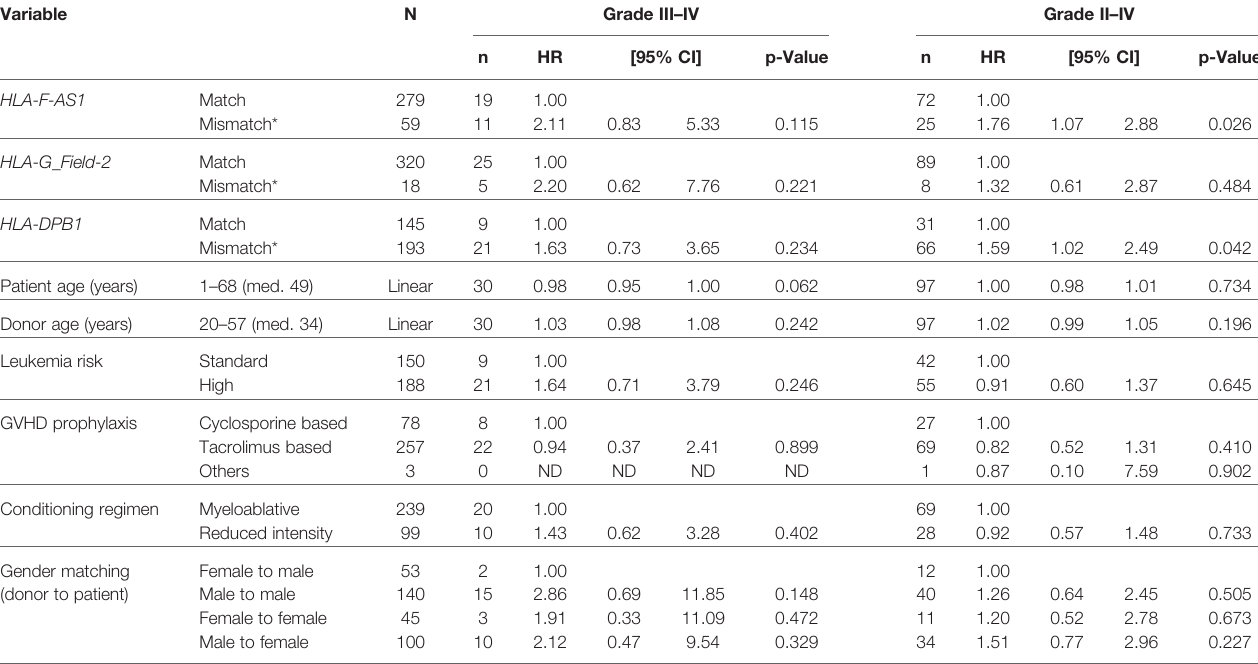
TABLE 5 | Effect of HLA-F-AS1 , HLA-G , and HLA-DPB1 mismatches on transplantation outcome by the multivariate analysis. Variable